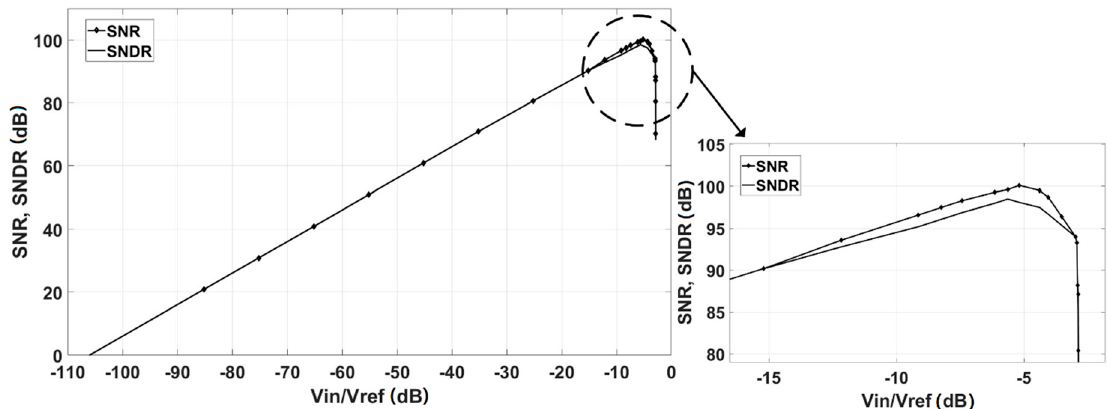
Figure 13. Measured signal-to-noise ratio (SNR) and signal-to-noise distortion ratio (SNDR) versus input amplitude (500 Hz bandwidth). Table 4. Performance summary.